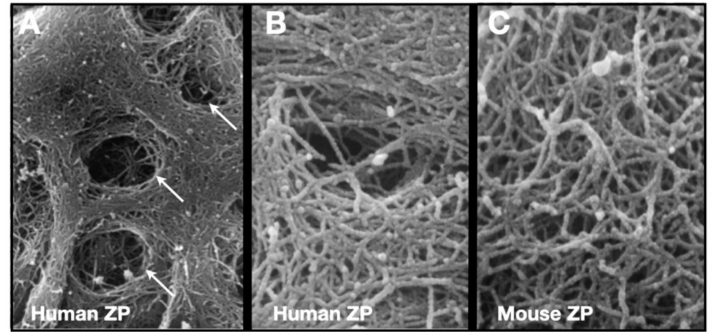
Figure 6. Scanning electron micrographs of the surface of human and mouse oocytes. ( A ) Human oocyte showing the presence of many pores (9000 × magnification) on the outer surface of the ZP. ( B ) Higher magnification of a human oocyte showing the fibrillar organization of the ZP (50,000 × magnification); fibrils are 0.1–0.4 µ m long and 10–14 nm wide. ( C ) Outer surface of a mouse oocyte showing the fibrillar organization of the ZP (50,000 × magnification). Samples were treated with saponin–ruthenium red–osmium–thiocarbohydrazide to reveal ZP fibrils. This figure was adapted with permission from G. Familiari ([113], Figure 3), Copyright